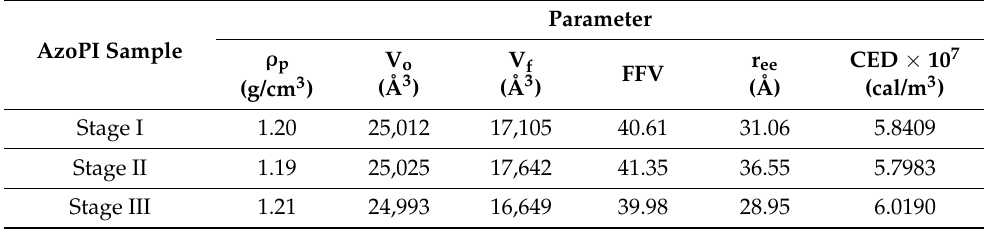
Table 3. Predicted parameters for the azo-polyimide systems studied by molecular simulation.